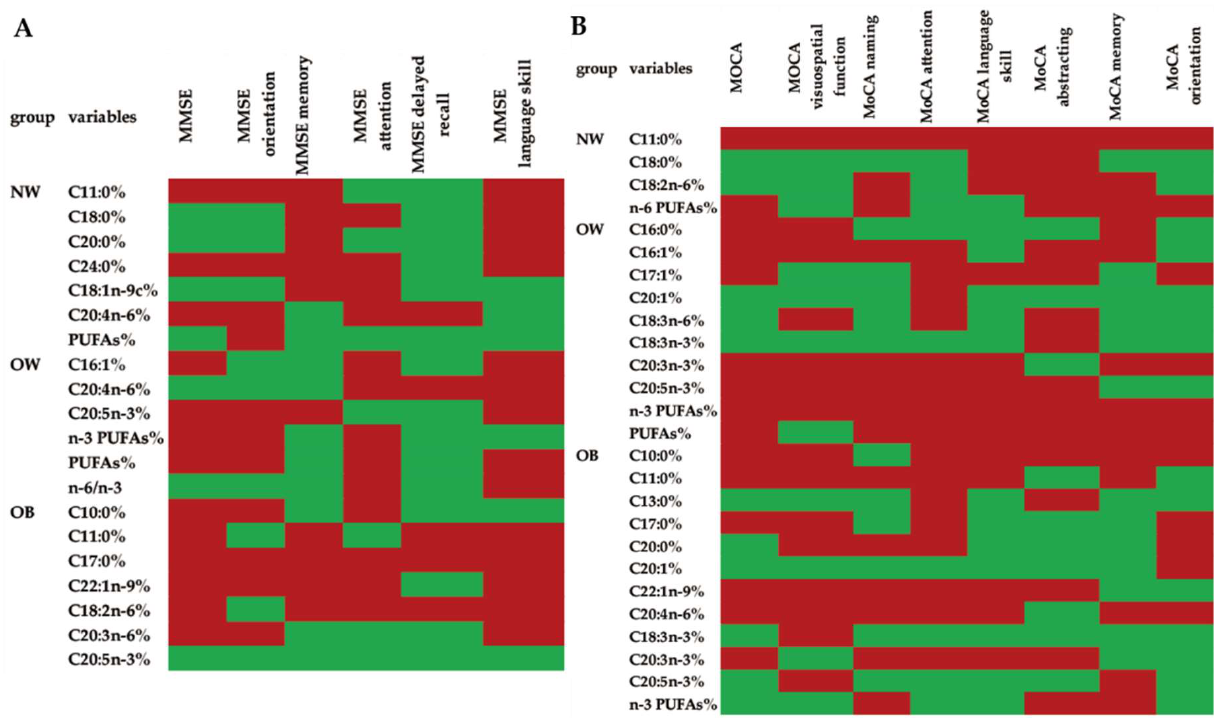
Figure 3. Correlations between the fatty acid compositions of the erythrocyte membranes in the three groups and their cognitive functions scores: heatmaps of the regression coefficients in a multiple linear regression. ( A ) Correlations between the fatty acid composition of the erythrocyte membranes in the three groups and the cognitive functions scores determined by MMSE. ( B ) Correlations between the fatty acid composition of the erythrocyte membranes in the three groups and the cognitive functions scores determined by MoCA. The red color indicates a negative correlation, while the green color indicates a positive correlation. Table 5. Associations between the scores in all of the cognitive domains measured by MMSE and the fatty acid composition of the erythrocyte membranes in the three groups.